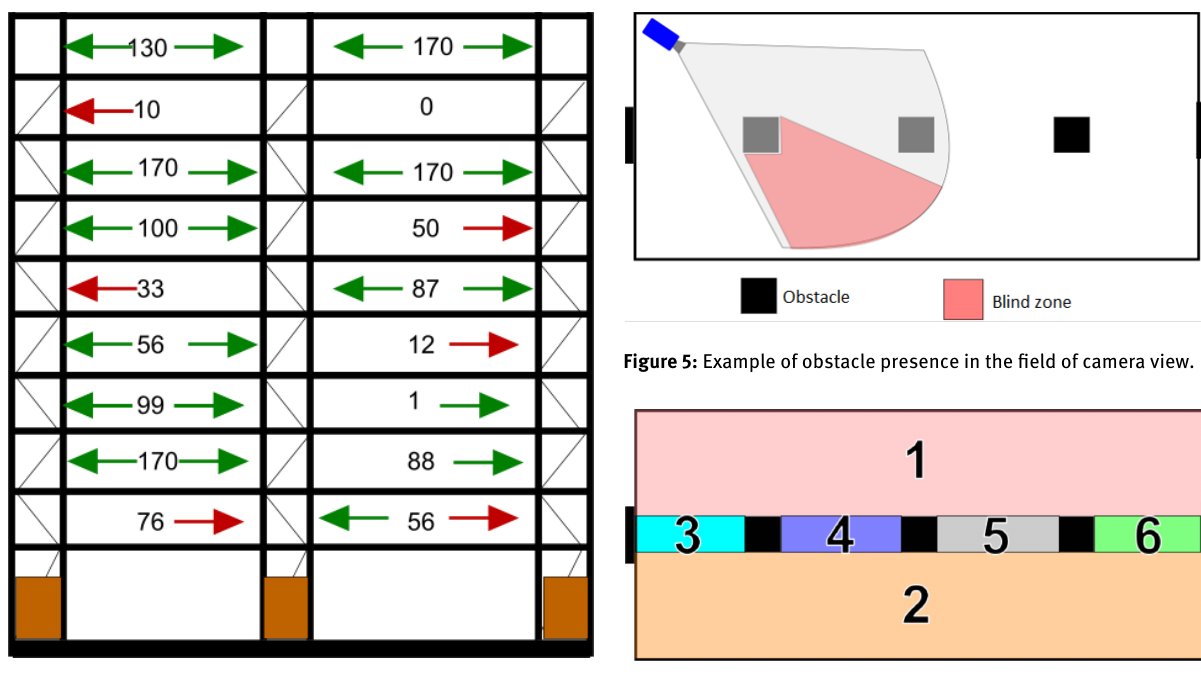
Figure 4: Dynamic evacuation model on the basis of people density information on each floor.